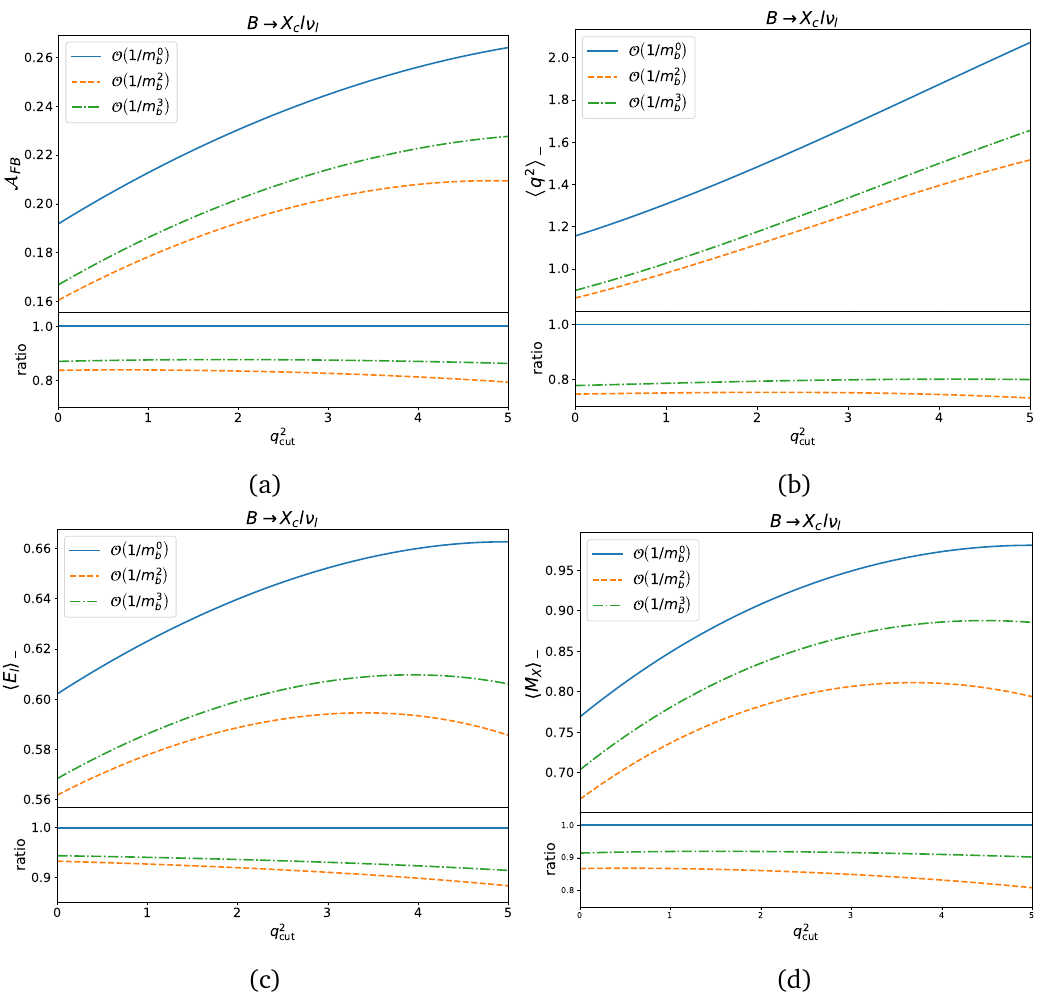
〉 2 and the 〈 . The solid, dashed and dash-dotted − as a function of q cut A FB O ( 1 / m 0 ) , ( 1 / m 2 ) and ( 1 / m 3 ) , respectively. b b b O O O ( 1 / m 0 ) b O